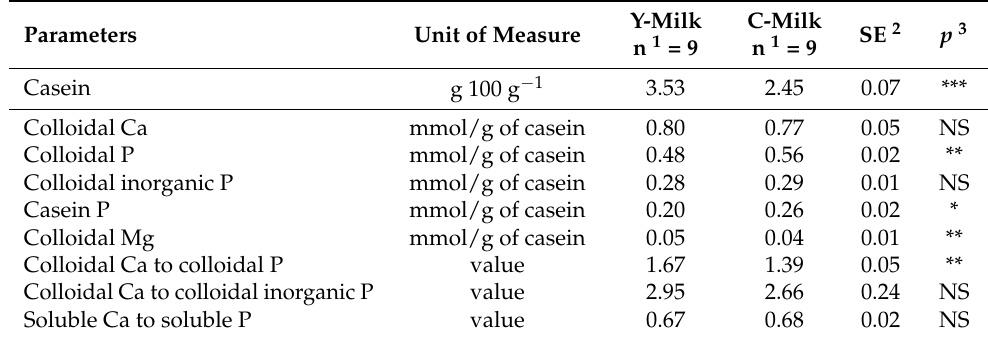
Table 3. Least-square means of Ca, P and Mg concentrations within the casein micelles of yak ( Bos grunniens , Y-milk) and cow ( Bos taurus , C-milk) milk. Y-Milk C-Milk Parameters Unit of Measure SE 2 p 3 n 1 = 9 n 1 = 9 Casein g 100 g − 1 3.53 2.45 0.07 *** Colloidal Ca mmol/g of casein 0.80 0.77 0.05 NS Colloidal P mmol/g of casein 0.48 0.56 0.02 ** Colloidal inorganic P mmol/g of casein 0.28 0.29 0.01 NS Casein P mmol/g of casein 0.20 0.26 0.02 * Colloidal Mg mmol/g of casein 0.05 0.04 0.01 ** Colloidal Ca to colloidal P value 1.67 1.39 0.05 ** Colloidal Ca to colloidal inorganic P value 2.95 2.66 0.24 NS Soluble Ca to soluble P value 0.67